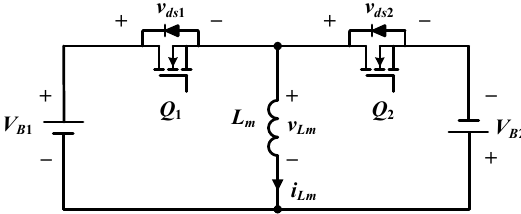
Figure 1. Bi-directional buck-boost circuit diagram.